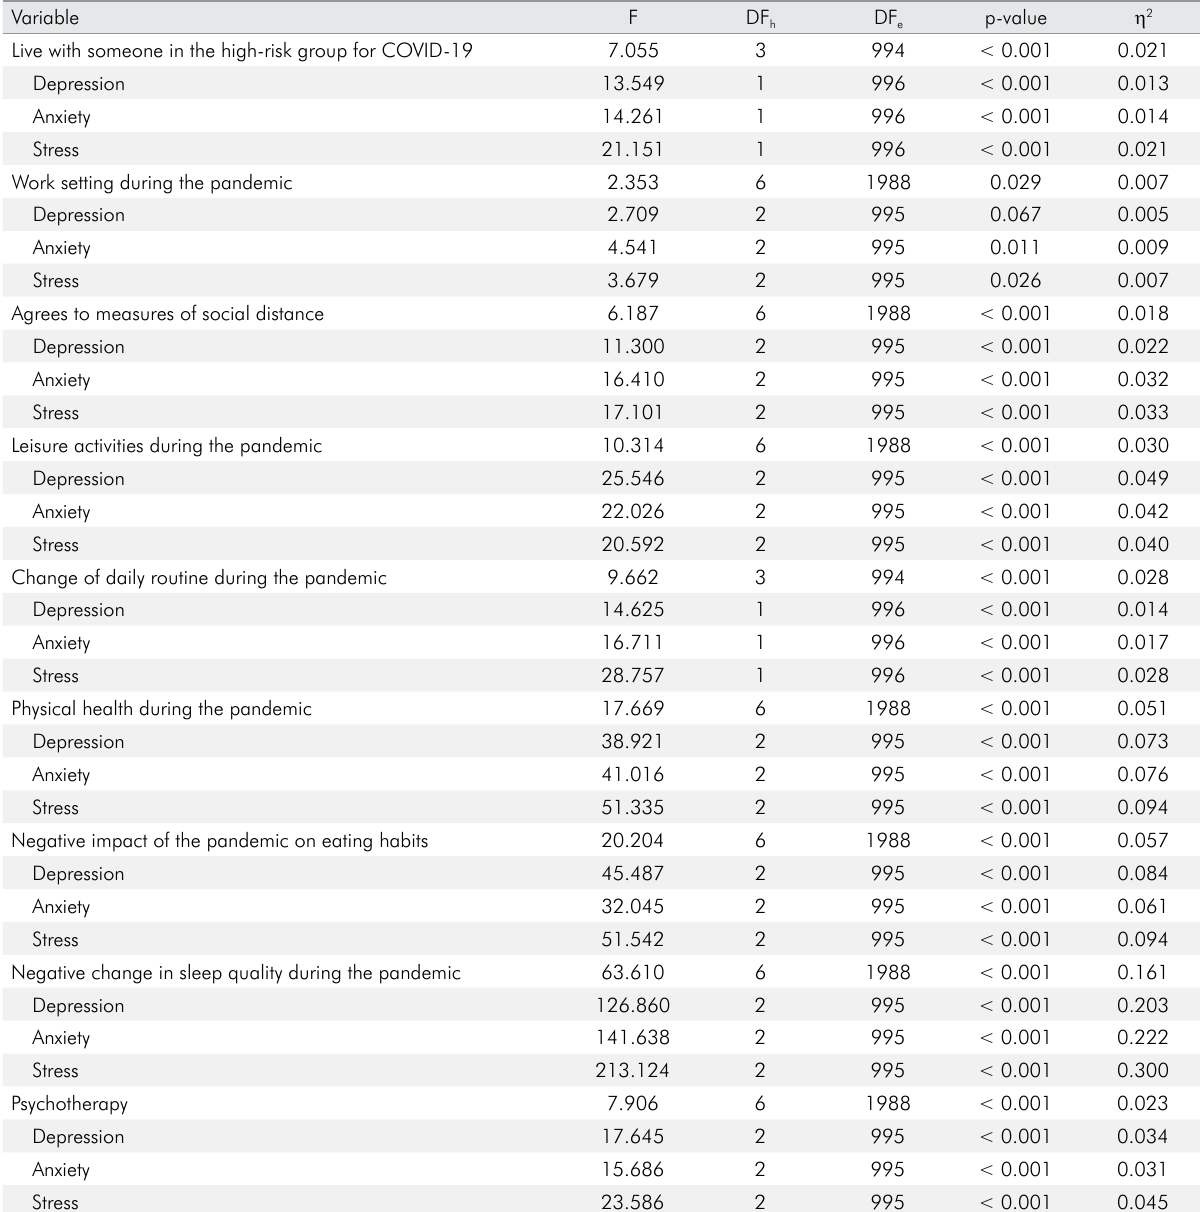
Table 4. Multivariate and univariate analysis of variance for depression, anxiety, and stress of Brazilian dental surgeons during the COVID-19 pandemic Variable